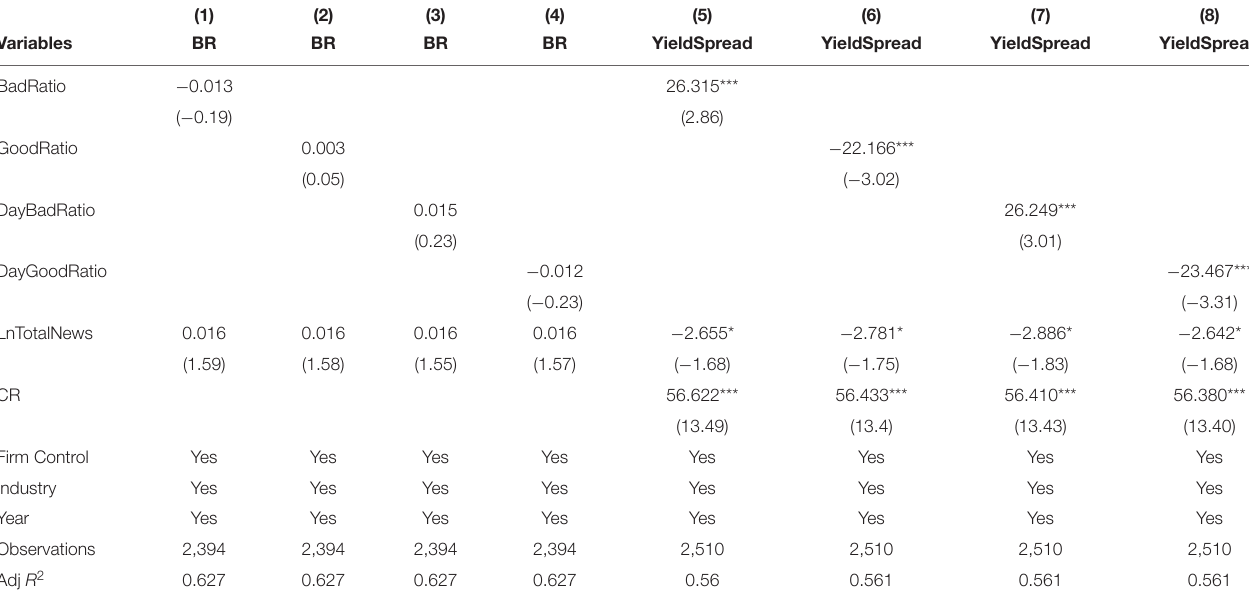
TABLE 4 | Result about how CRAs and bond investors react toward financial news on the